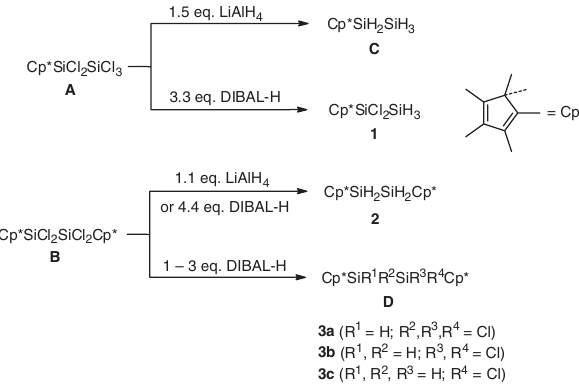
Scheme 1: Reaction of Cp*-substituted disilanes with diisobutylalu- minum hydride (DIBAL-H) and LiAlH